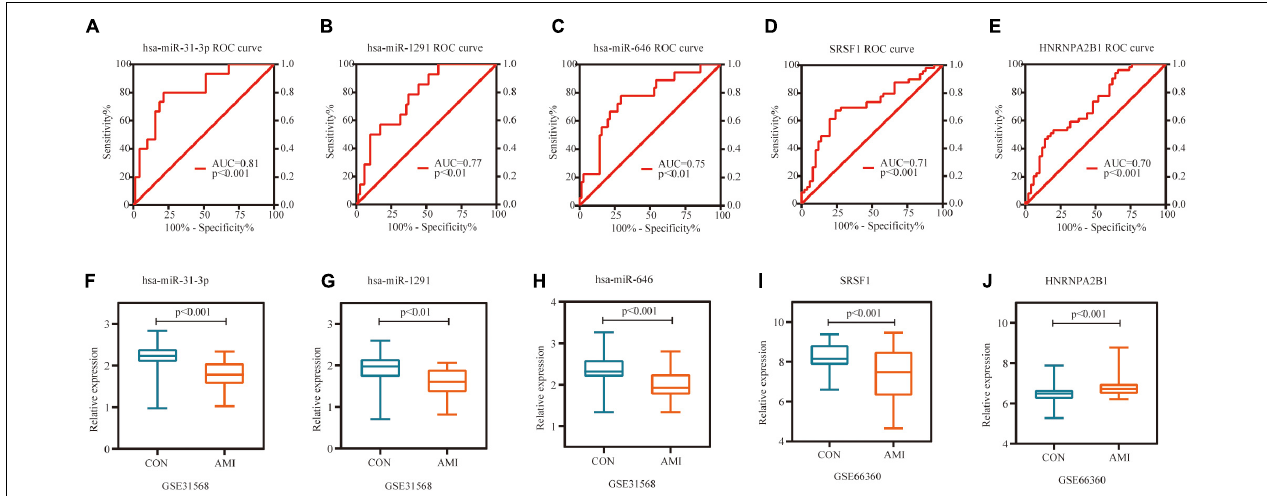
FIGURE 8 | Potential biomarkers in datasets. (A) ROC curve of hsa-miR-31-3p in GSE31568. (B) ROC curve of hsa-miR-1291 in GSE31568. (C) ROC curve of hsa-miR-646 in GSE31568. (D) ROC curve of SRSF1 in GSE66360. (E) ROC curve of HNRNPA2B1 in GSE66360. (F) The relative expression of hsa-miR-31-3p in